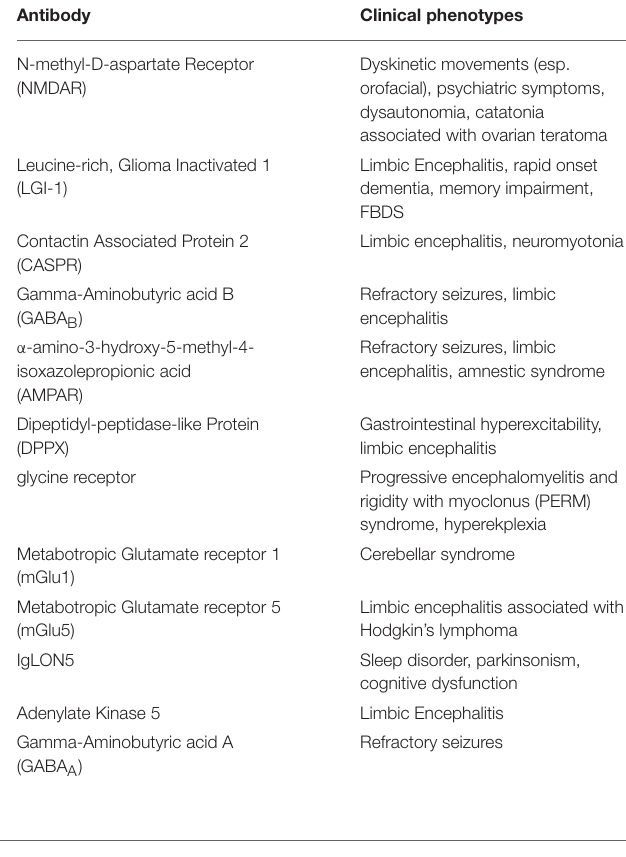
TABLE 2 | Cell-surface Antibody associated AIE subtypes.